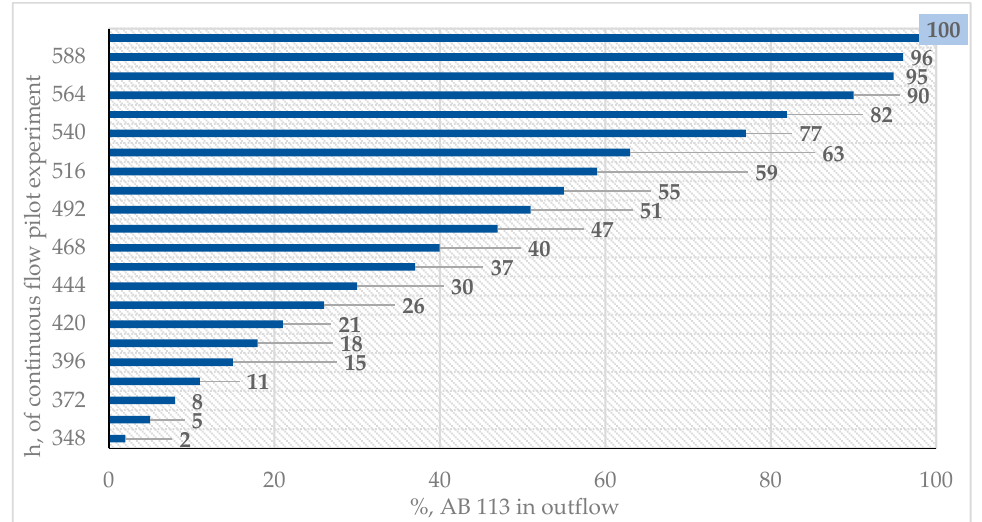
Figure 9. Graphical representation of AB 113 dye existing in outflow.